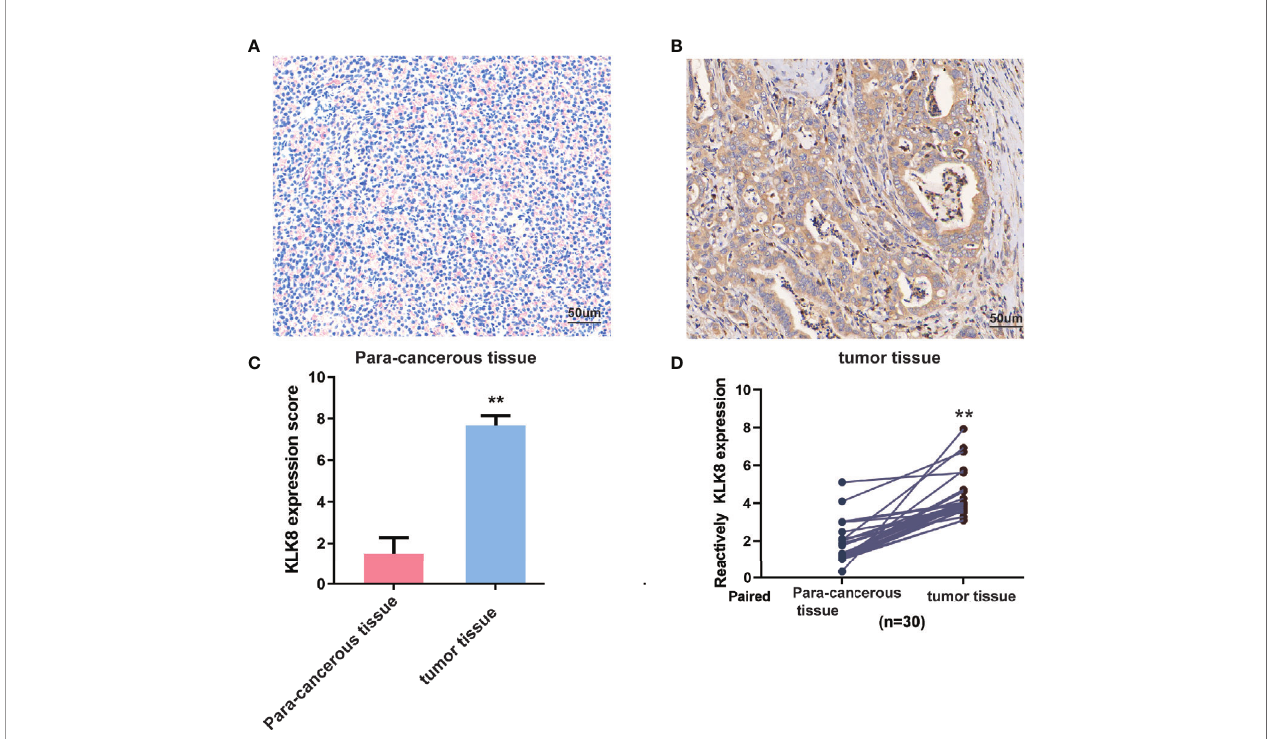
FIGURE 2 | KLK8 expression in pancreatic cancer tissues and para-cancerous pancreas. (A, B) Representative immunohistochemistry staining of KLK8 in pancreatic cancer tissues and para-cancerous pancreas (n=20). (A) showed negative KLK8 staining in para-cancerous pancreas. (B) showed strong positive KLK8 staining in PDAC tissues. (C) Quanti fi ed data of the score for KLK8 staining. (D) Quantitative real-time PCR detection of KLK8 mRNA expression in paired human PDAC tissue samples and para-cancerous pancreas (n=30). Data were presented as the mean ± SEM. **p < 0.01 vs Non-tumor tissue.